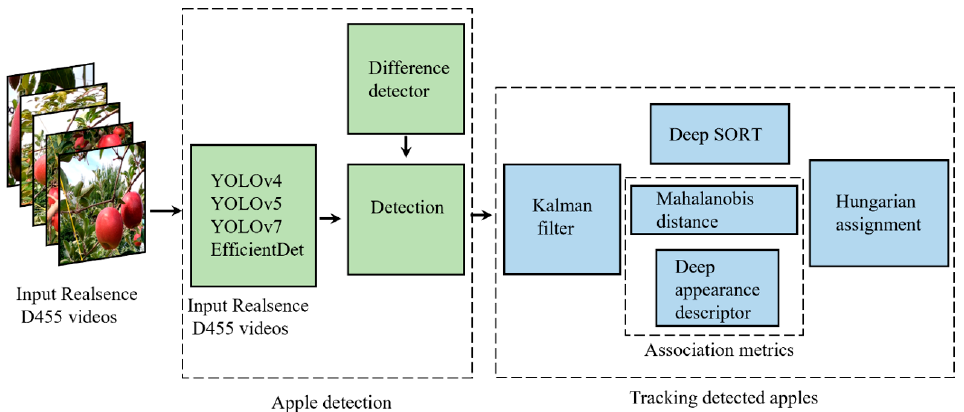
Figure 13. Architecture of the Deep SORT algorithm for tracking detected apples.